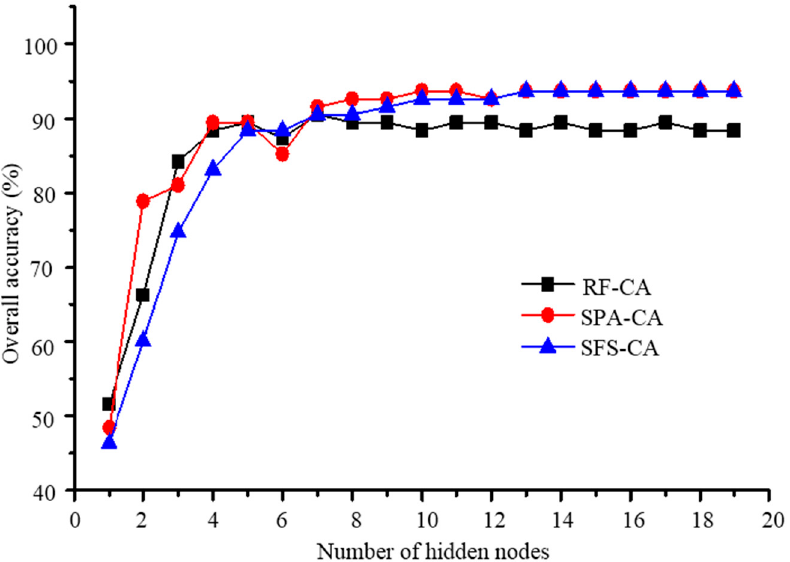
Figure 5. The discriminant results of the extreme learning machine (ELM) model based on optimal wavelengths selected by RF-CA, SFS-CA and SPA-CA under different hidden nodes.